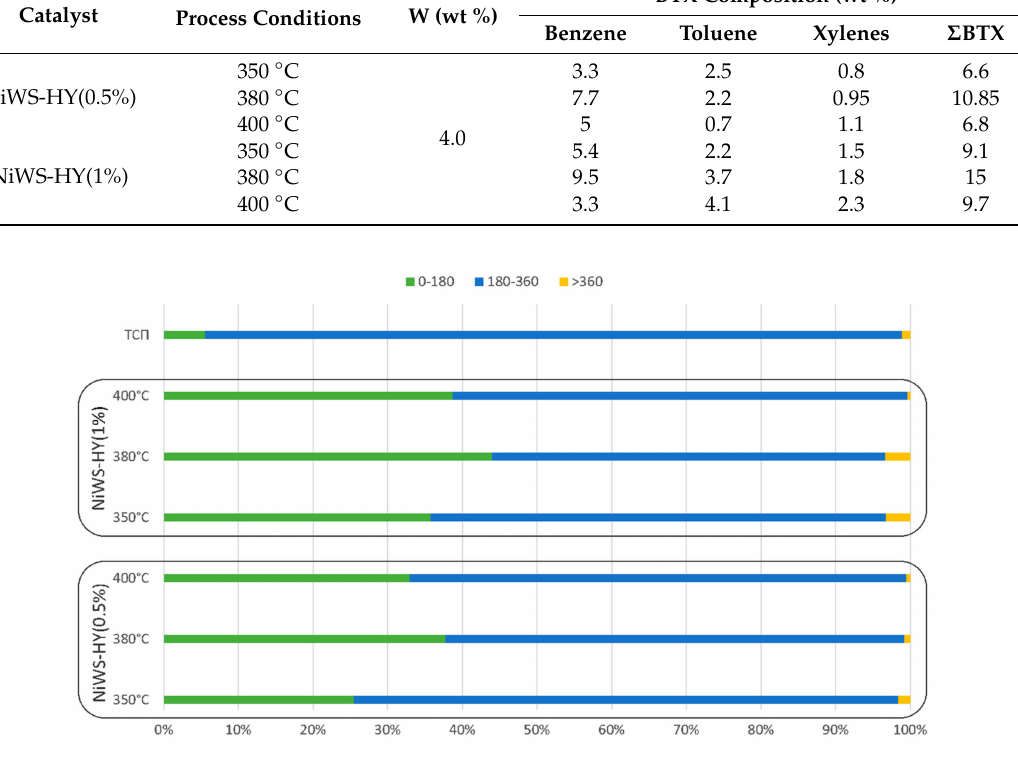
Figure 3. Fractional composition of HPR hydrocracking products with NiWS-HY(0.5%), NiWS-HY(1%) catalysts at constant mass content W = 4% and at standard conditions ( p = 5 MPa, t = 5 h, and W:Ni ratio = 1:2).